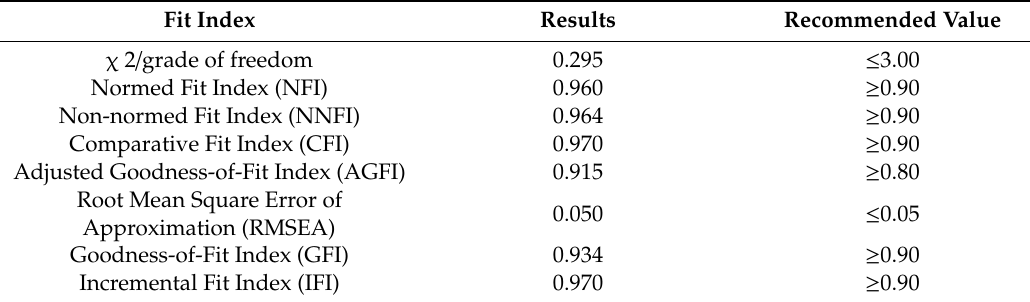
Table 4. Overall fits of the models